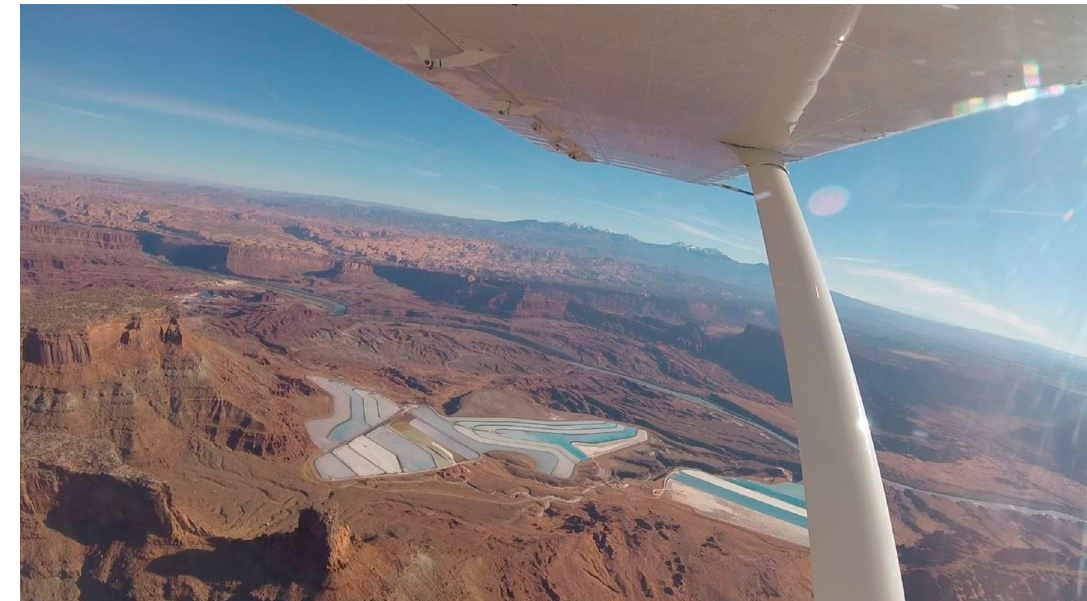
Figure 5. Potash settling ponds. The Texas Gulf Sulphur Company’s potash settling ponds can be seen from Dead Horse Point State Park and from some approach roads to Canyonlands. The company’s operation started before Canyonlands was established. Photograph by Tatyana Martello, November 2018.